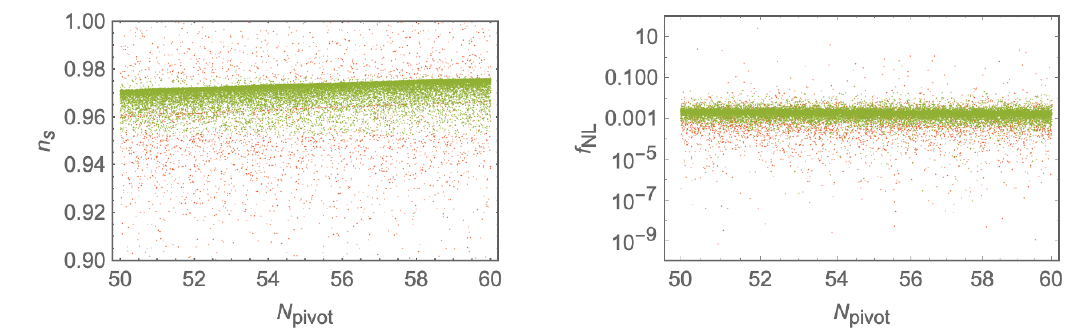
Figure 2 . Left panel: a plot of the ratio n s vs. N pivot in the range 50{60 for the same data set as in (cid:12)gure 1. The plot shows a mild dependence of n s on N pivot in the range indicated. Right panel: the same as the left panel except f equil is plotted vs. N pivot . The green and red dots are parameter NL points and have the same meaning as in (cid:12)gure 1.